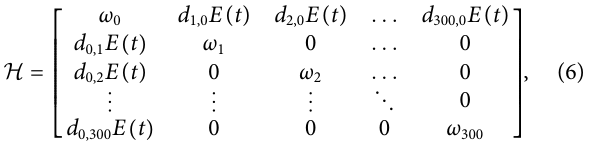
Frontiers in Physics |